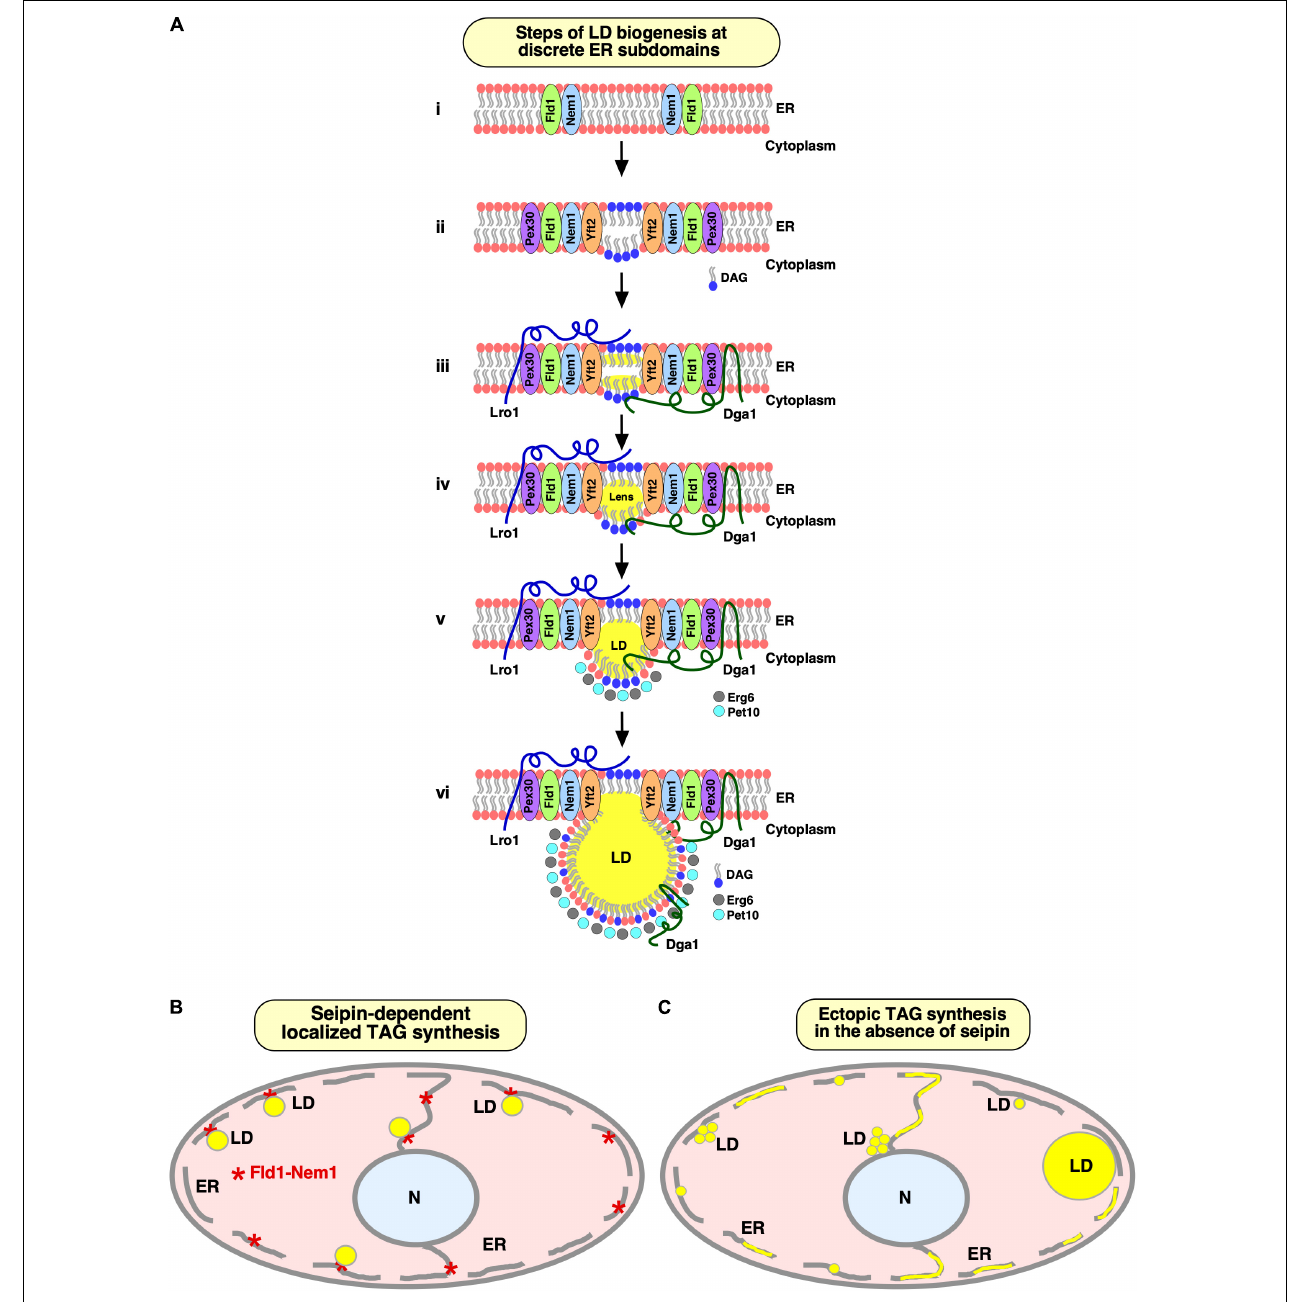
FIGURE 2 | Specialized ER subdomains engaged in LD biogenesis. (A) Steps of LD biogenesis from discrete ER subdomains. (i) Seipin/Fld1 and Nem1 localize to discrete domains in the ER in LD-deficient yeast cells. Colocalization of Fld1 and Nem1 (Fld1/Nem1 sites) results in activation of Nem1 at these sites. (ii) The phosphatidate phosphatase, Pah1, gets activated and catalyzes production of DAG at Fld1/Nem1 sites. Locally enriched DAG then drives the recruitment of Yft2 and Pex30 to these sites. Deformation of the ER bilayer is facilitated by Pex30 to accommodate DAG and/or TAG. (iii, iv) Fld1/Nem1/Yft2/Pex30 containing ER subdomains become functional in recruiting the TAG-synthesizing enzymes: Dga1 and Lro1 to these sites, resulting in the localized production of neutral lipids (iii), and formation of neutral lipid lenses (iv). (v, vi) Neutral lipid lenses grow into nascent LDs (v). LD scaffolding proteins, such as Pet10, and sterol biosynthetic enzymes, such as Erg6, recognize nascent LDs and facilitate their emergence toward the cytoplasm (v), where they further mature (vi). Mature LDs remain connected to the ER via a hemi-membranous bridge at ER–LD contact sites to facilitate bidirectional transport of lipids and proteins between the two compartments in a dynamic fashion. This figure has been modified from 2020 Choudhary et al. Originally published in the Journal of Cell Biology (https://doi.org/10.1083/jcb.201910177). (B,C) Seipin facilitates localized droplet assembly. Cartoon depicting seipin-marked ER sites at which localized TAG synthesis drives formation of nascent LDs, which remain associated with the ER at their site of biogenesis (B) . Lack of seipin results in ectopic TAG synthesis throughout the ER and formation of a heterogenous population of tiny, large, and clustered LDs (C) .